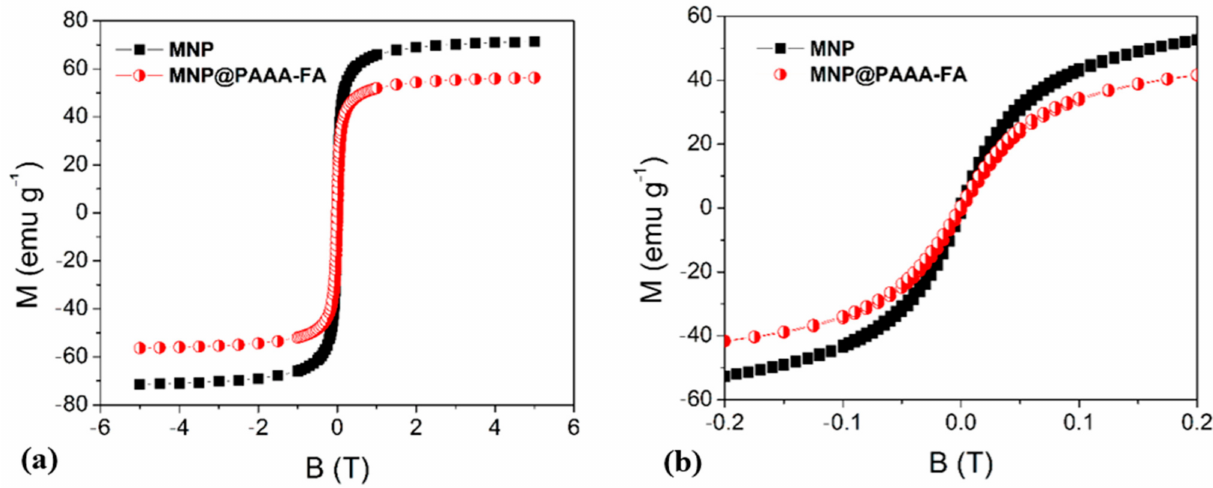
Figure 4. Magnetization vs. applied magnetic field for uncoated MNP and magnetic nanostructures MNP@PAAA-FA ( a ) and magnetization cycles at the low magnetic field ( b ) measured at room temperature using 0.02 g of dried